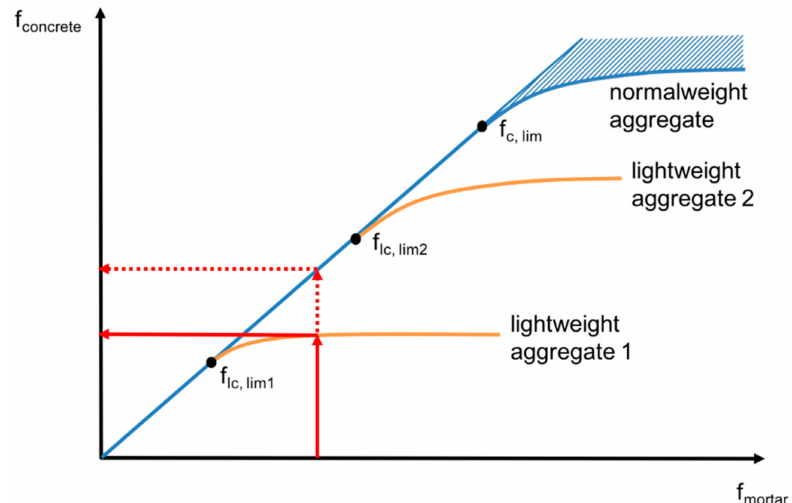
Figure 5. Explanation of limit strength (f lc,lim ) of di ff erent types of lightweight and normal weight aggregate